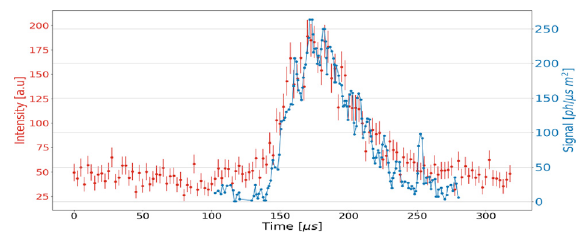
Figure 9. Blue: The lightcurve of the TUS161003 event as seen by TUS [26]. Even though the event has probably an anthro- pogenic origin, it presents all the features of an EAS signal. Red: An event detected by Mini-EUSO near lake Michigan. It presents the same time profile of the event seen by TUS, even though it is ∼ 10 times brighter. It is produced by a ground source in an area near three small airports. Image adapted from